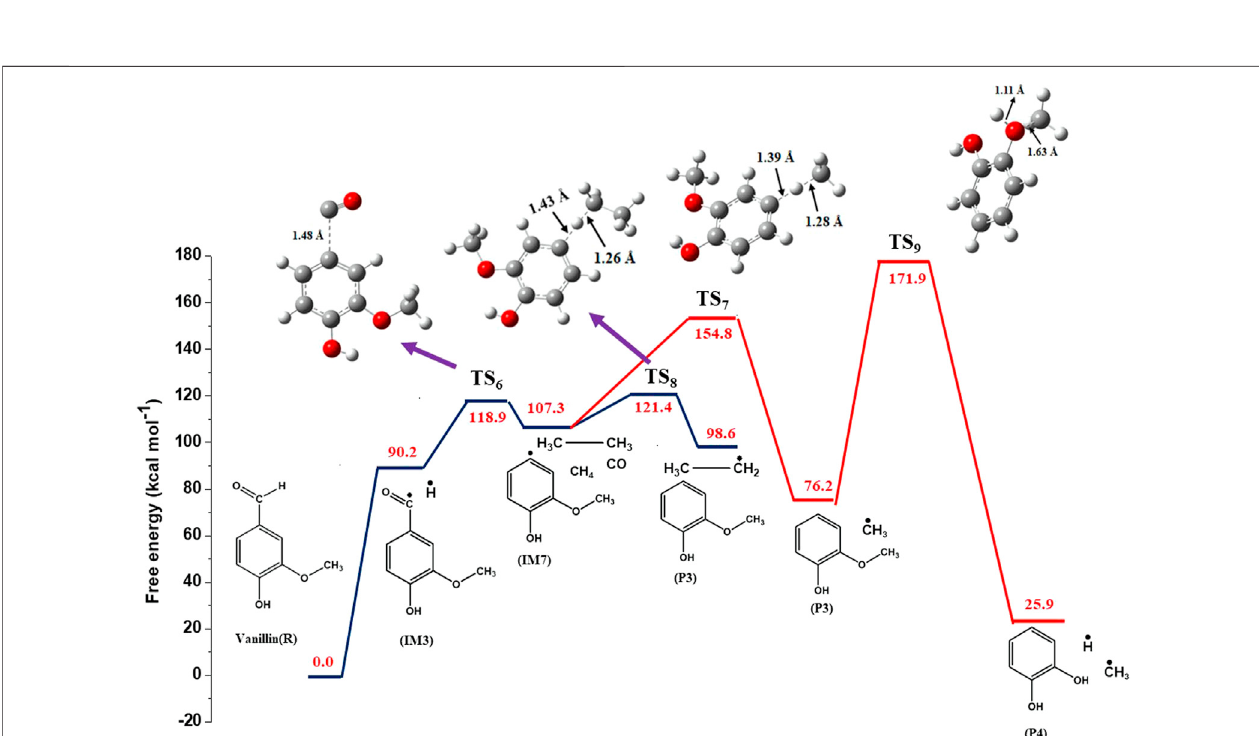
FIGURE 4 | Potential energy pro fi le for the transformation of vanillin to guaiacol.